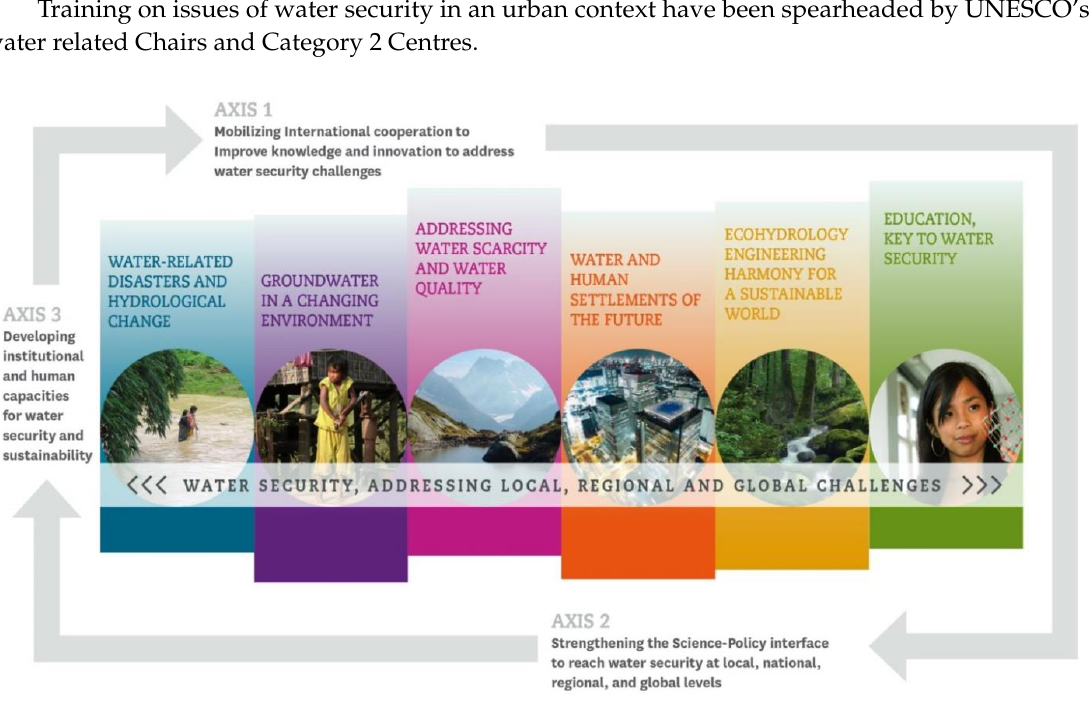
Figure 3. IHP VIII (2014–2021); Water Security: Responses to Local, Regional and Global Challenges.